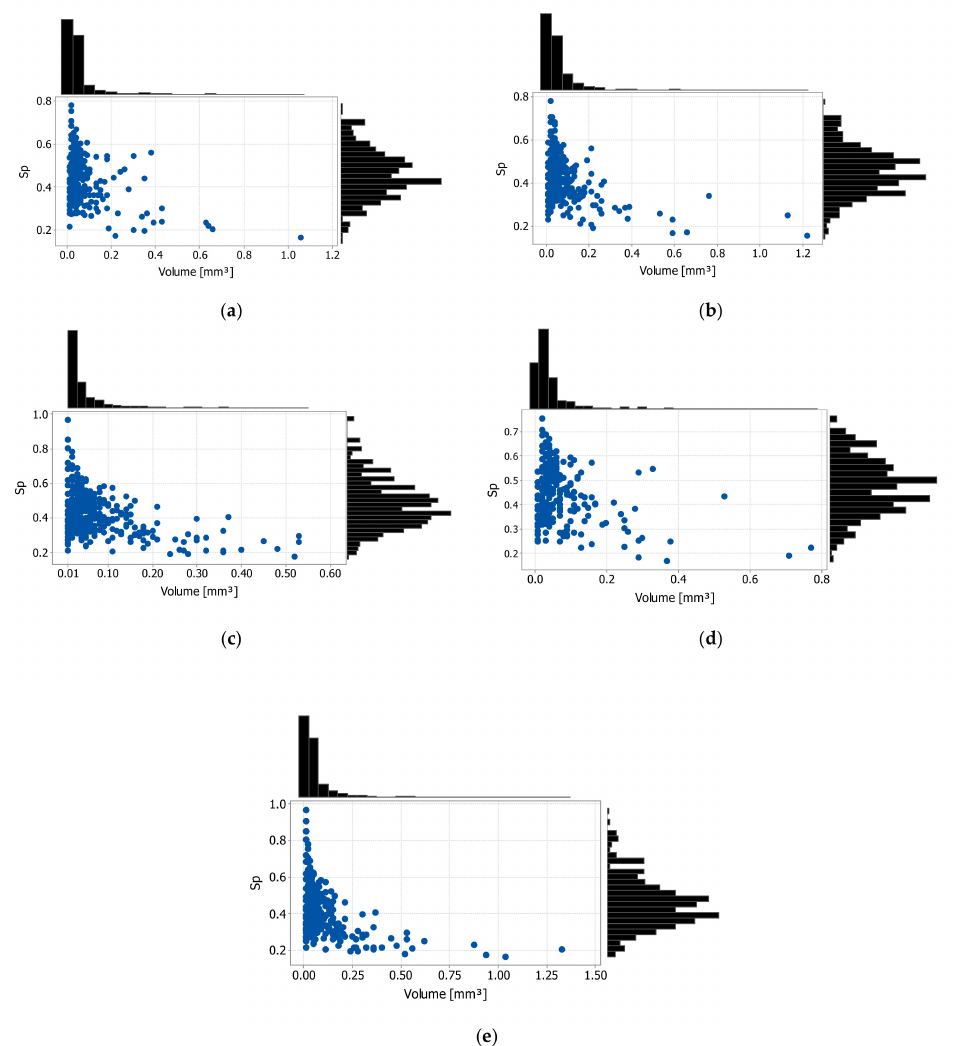
Figure 16. The sphericity (Sp) parameter of closed pores for: ( a ) sample S1; ( b ) sample S2; ( c ) sample S3; ( d ) sample S4; ( e ) sample S5.